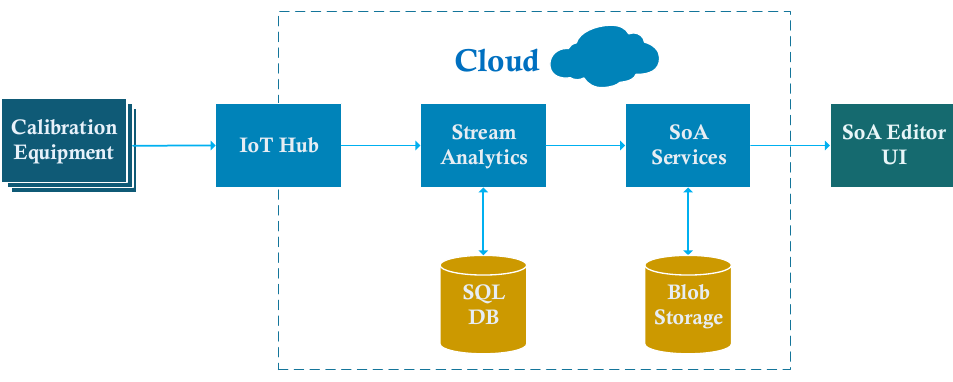
Figure 7. Overall system architecture.